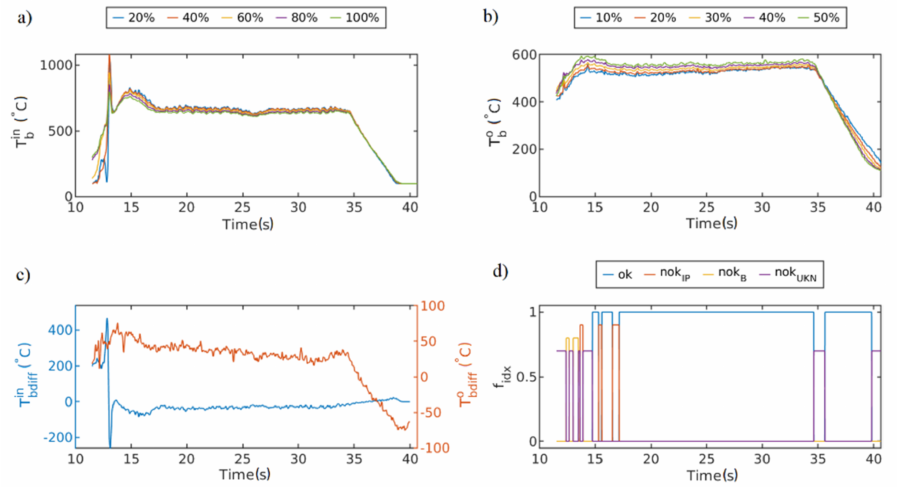
, ( c ) diagnostic signals T in b bdif f